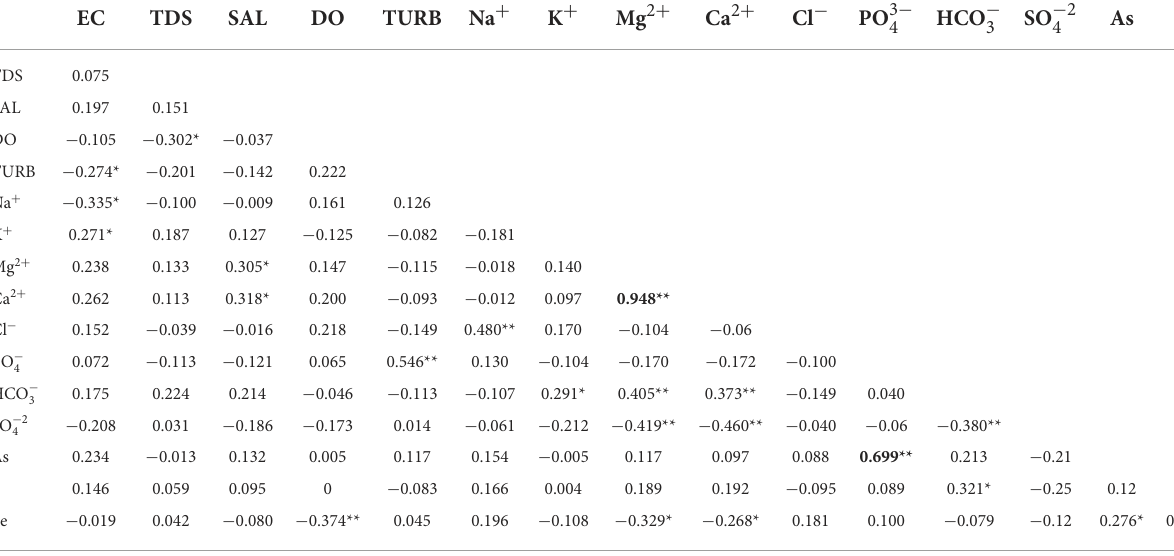
TABLE 3 Displaying the correlation matrix obtained using SPSS software.